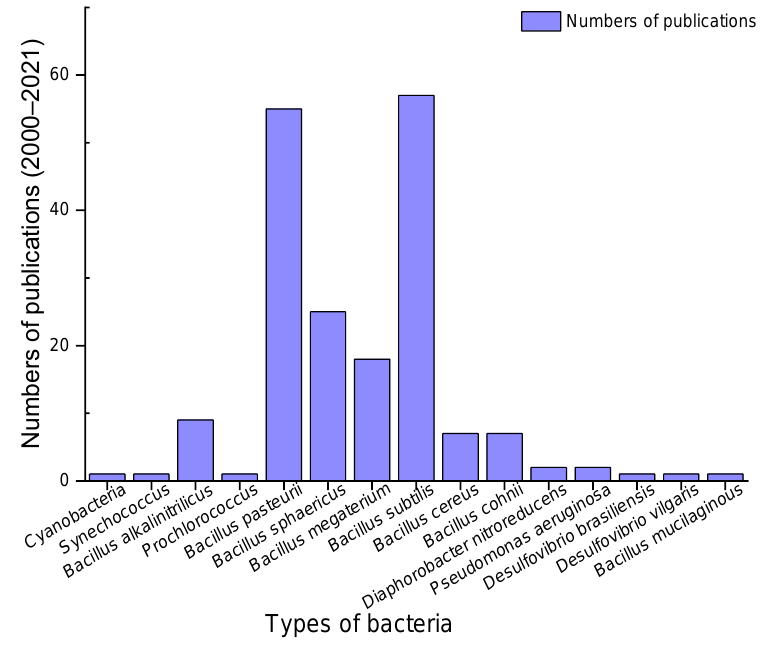
Figure 1. Numbers of publications of bacteria related to BSHC.